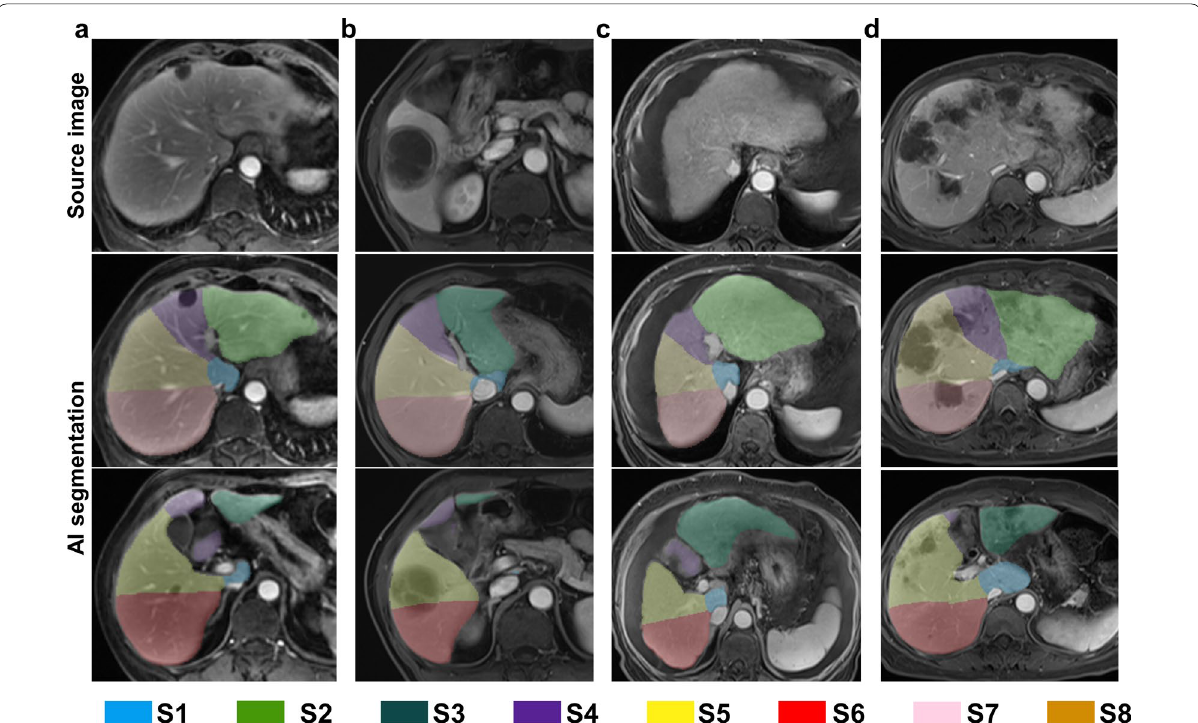
Fig. 4 Examples of successful segmentations from AI in the clinical evaluation set. a A good liver background with several hepatic cysts in separate segments. b A case of a large solitary liver abscess occupying 2 segments of the liver (S5 and S6). c Liver cirrhosis. d Liver metastases (multiple masses and nodules in the liver). The top row shows the original images. The middle row shows the upper part of the liver with segmentation masks from AI, and the last row shows the lower part of the liver. AI, artificial intelligence; S,